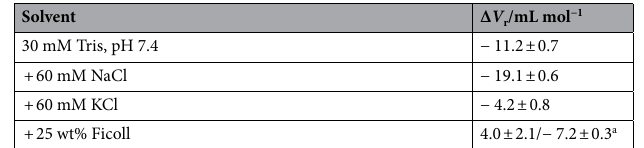
Table 4. Reaction volumes (Δ V r ) for the complex formation between 22AG and ThT at the temperature of 25 °C. The Δ V r values were obtained from the slope of ln K b vs. p , which yields—Δ V r /( RT ). a The first value and the second value refer to the volume change in the 1–1000 bar and 1000–2000 bar pressure range, respectively.